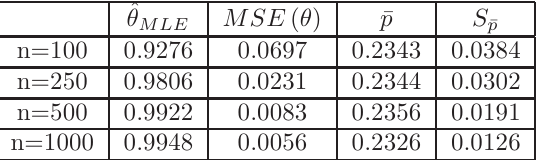
Simulations for Cox PH model, Binomial